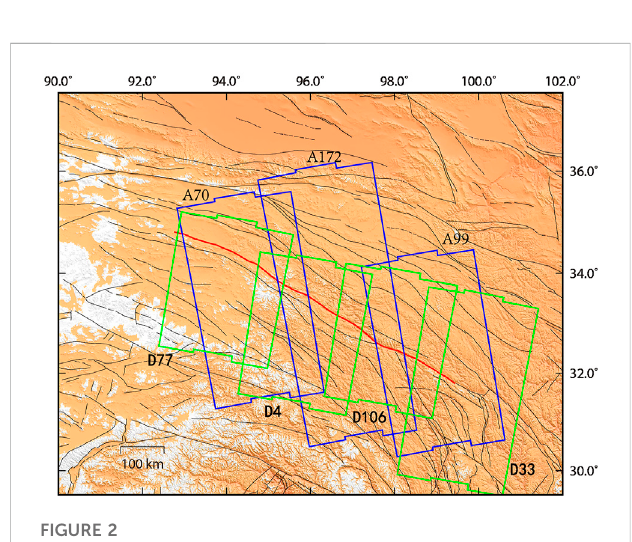
Regions monitored by ascending and descending tracks of Sentinel-1. blue and green rectangles indicate areas covered by ascending and descending Sentinel-1